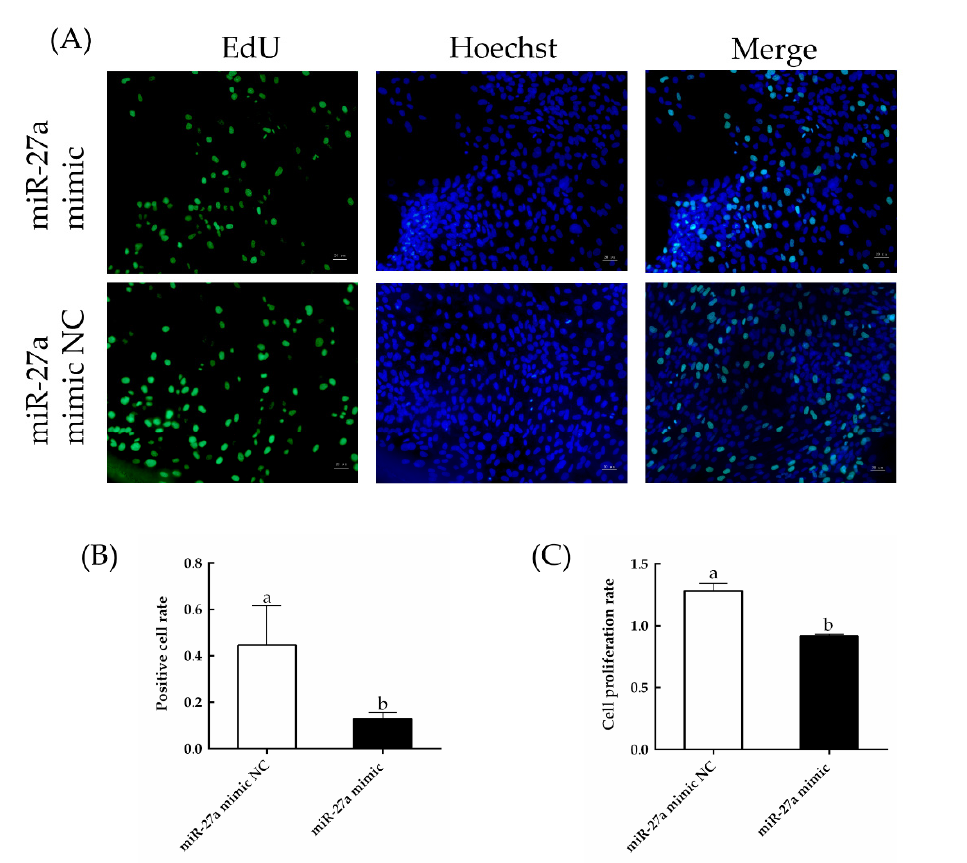
Figure 8. Effects of transfection of a miR-27a mimic on the proliferation of HFSCs. ( A ) HFSC proliferation was measured by EdU assays 24 h after transfection. ( B ) The rate of EdU-positive staining was quantified and is expressed as the number of EdU-positive cells divided by the total number of cells. ( C ) The proliferation of HFSC cells transfected with miR-27a or control was measured with CCK-8 assays. The different small letters (a, b) in the same graph indicate that the difference between groups is statistically significant ( p < 0.05).